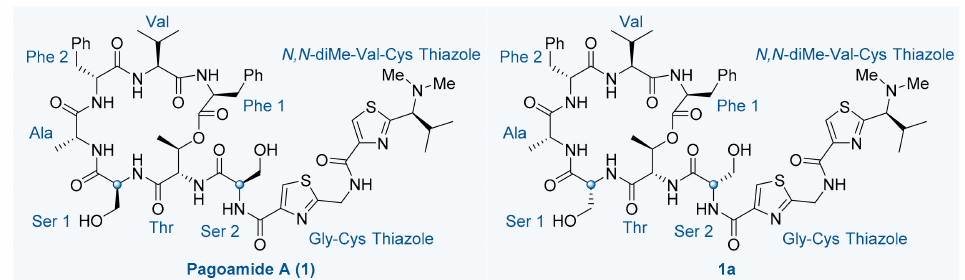
Figure 1. Structure of Pagoamide A ( 1 ) and its diastereomer ( 1a